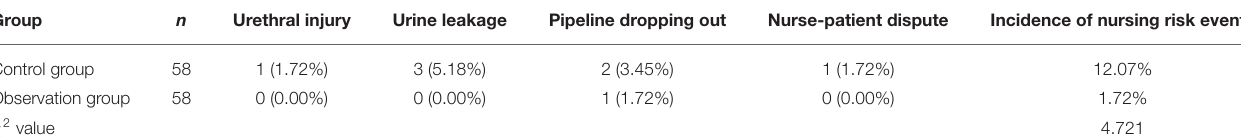
TABLE 2 | Comparison of the incidence of nursing risk events during treatment between the two groups. Group